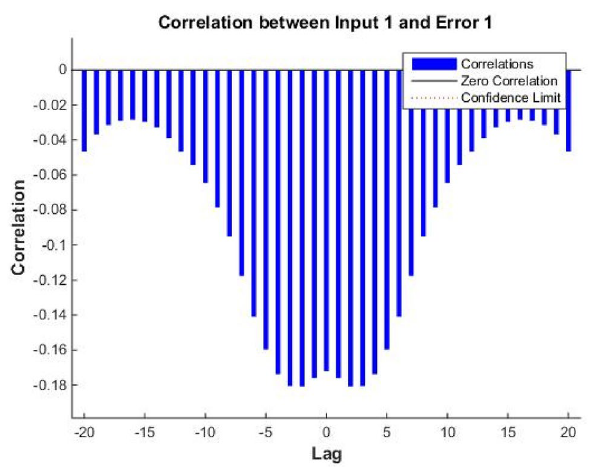
Figure 8. Input and output error correlation